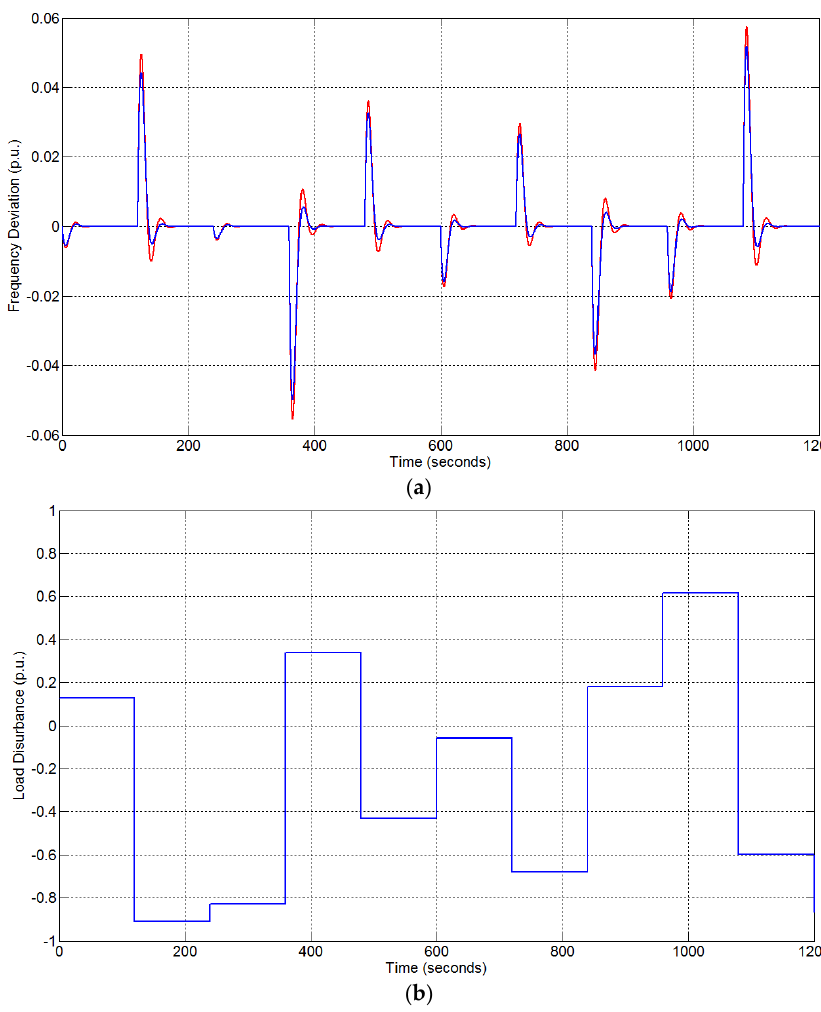
Figure 9. ( a ) AVB-enabled (blue/solid) and UDP-enabled (red/dashed) frequency regulation performance over a 20-min test period. ( b ) Load change profile.